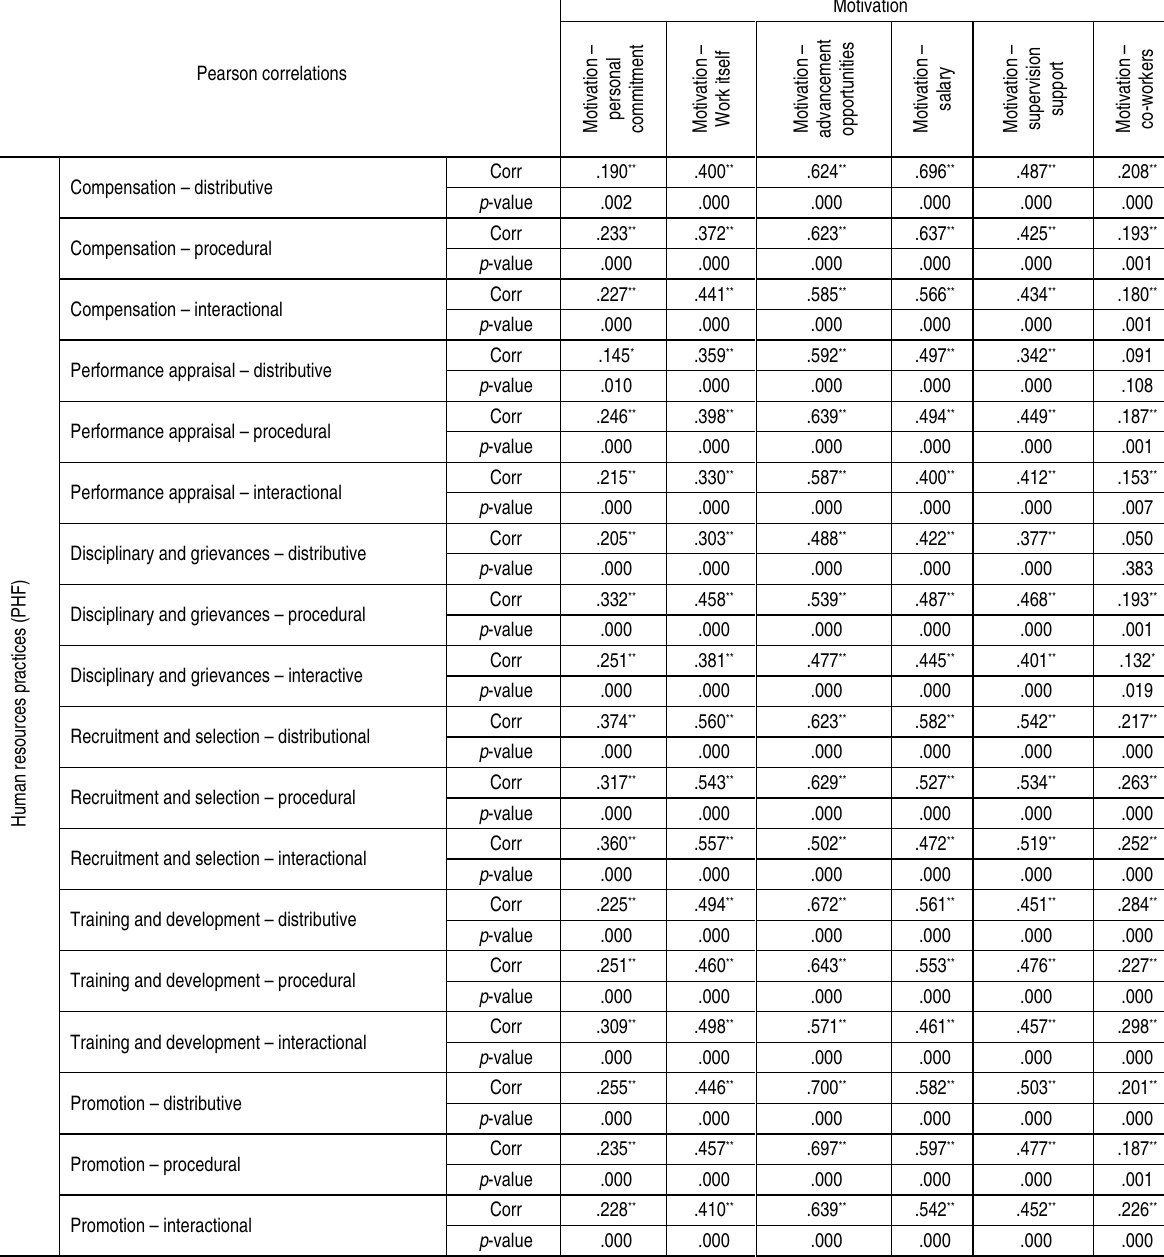
Table 3. Perceived HRM fairness (PHF) versus employee motivation (MOT)